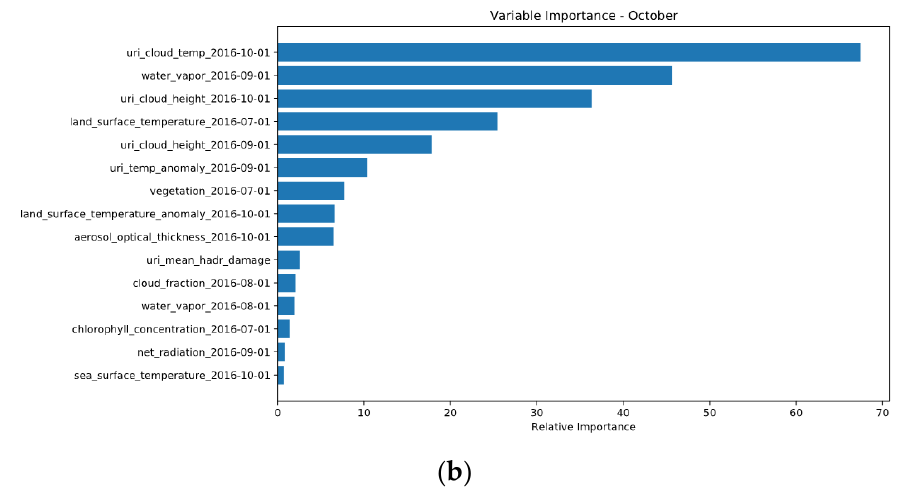
Figure 3. ( a ) Weighted sum model for cholera risk. ( b ) Relative feature importance for the XGBoost regression model for October.